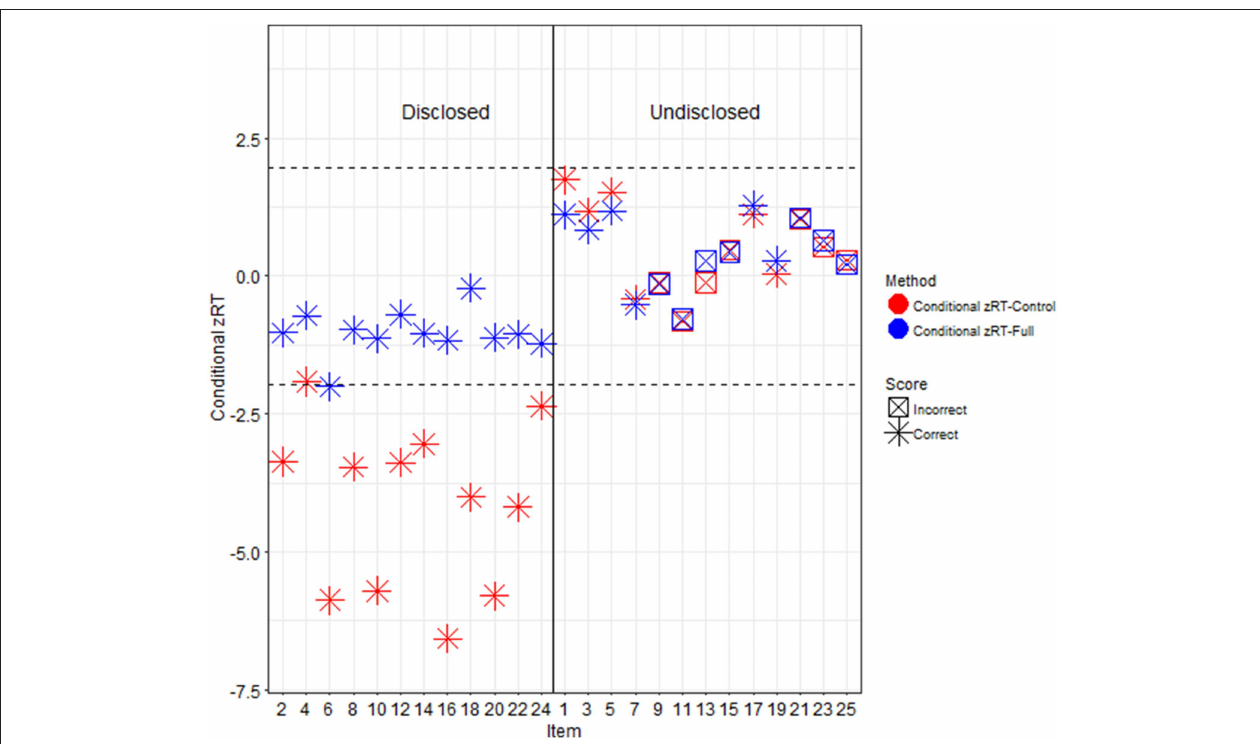
FIGURE 4 | Conditional zRTs computed with different comparison groups. The conditional zRTs for one Item + Answer participant computed with all participants as the comparison group are presented in blue and with only control participants as the comparison group in red. The dashed lines represent z- scores of ± 1.96; it is expected that 95% of the distribution of conditional zRTs will fall in between these lines. When all participants were used as the comparison group, the disclosed and undisclosed items appeared similar in terms of conditional zRTs, but when only control participants were used as the comparison group, the disclosed items for this participant appeared to be much more